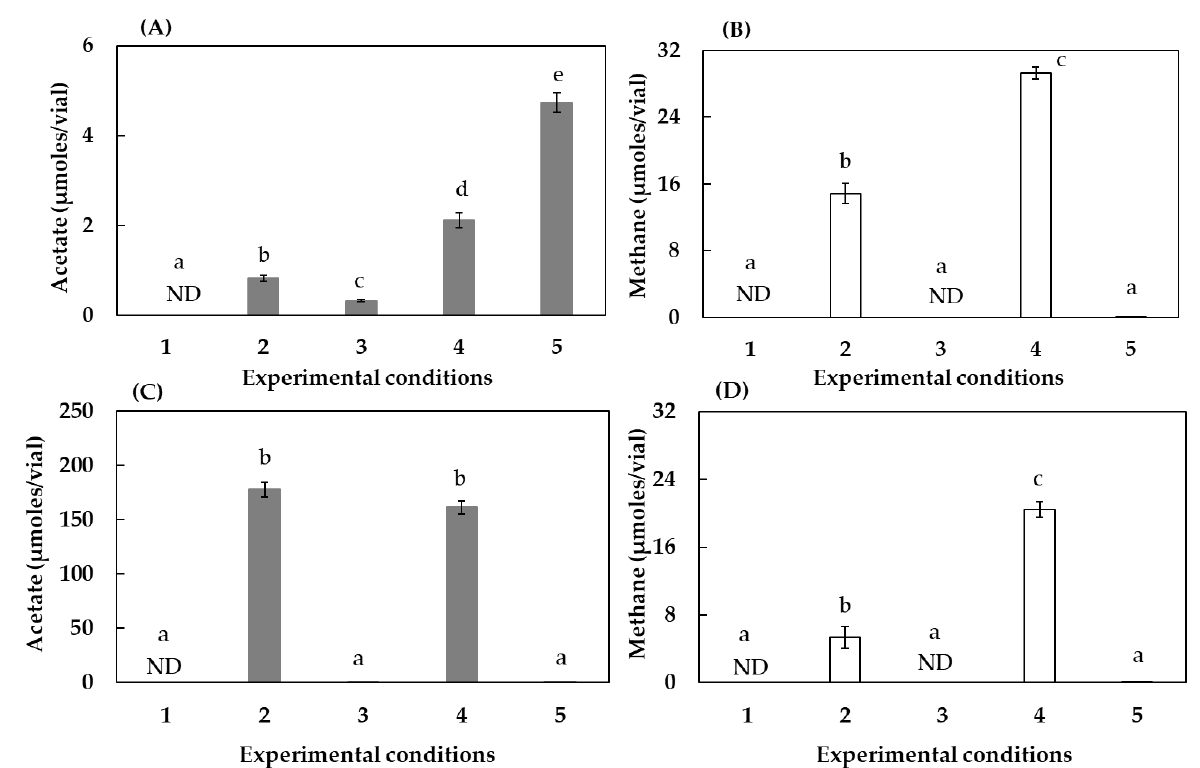
Figure 1. Effect of humin and H 2 on the production of acetate and methane in the HL ( A , B ) and HOA ( C , D ) consortia, respectively. Conditions 1 to 5 are summarized in Table 1. Vertical bars represent the standard deviation. Different letters show the statistically significant difference ( p < 0.05) by one-way ANOVA followed by Tukey’s post hoc test. ND: not